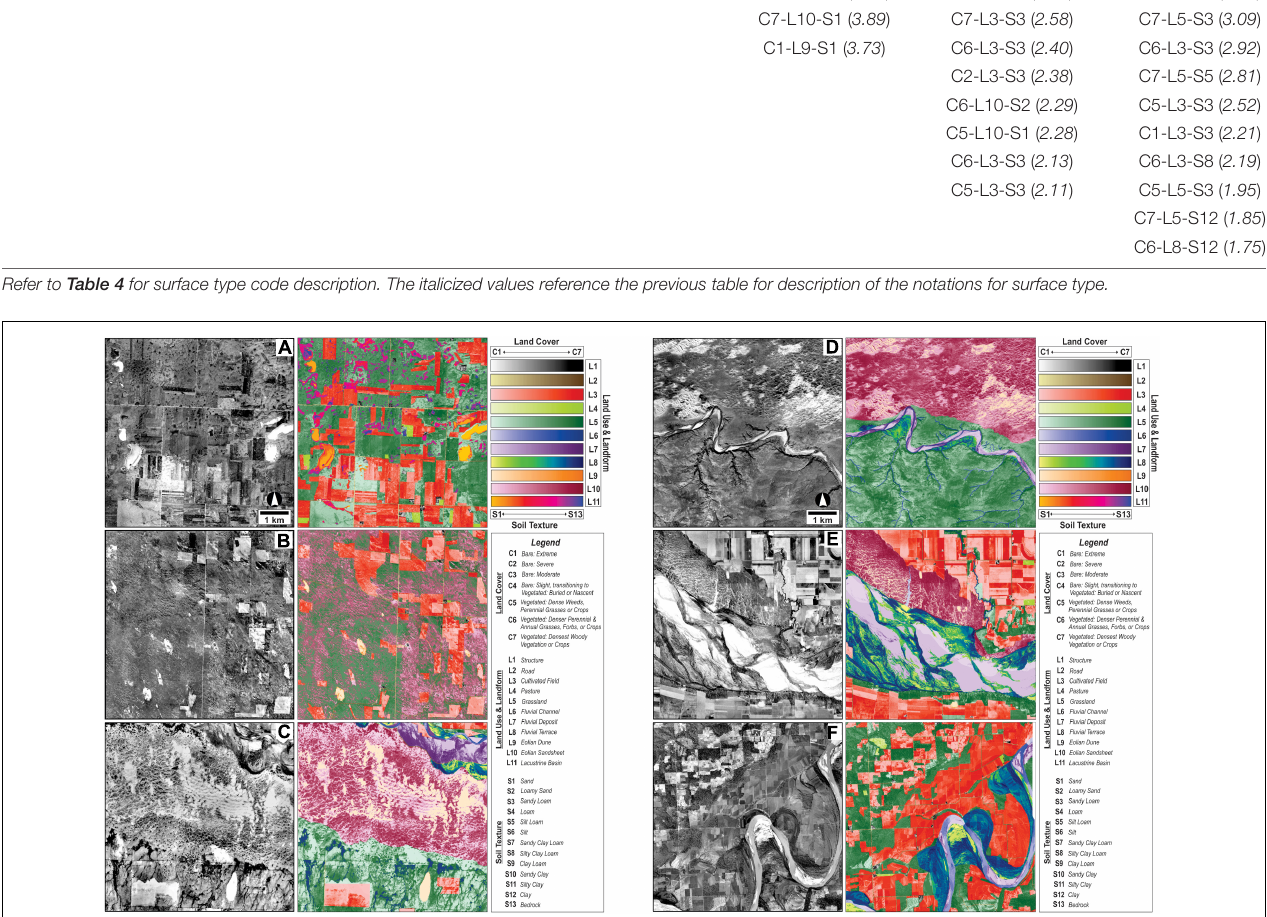
FIGURE 7 | Illustrative samples from image analysis and classification from processed aerial photographs of (A) Ward County, ND, (B) McPherson County, NE, (C) Hamilton County, KS, (D) Quay County, NM, (E) Tillman County, OK, Wilbarger and Wichita Counties, TX, and (F) Choctaw County, OK, Lamar and Red River Counties, TX. Refer to the corresponding letter in Figure 6 for location denoted by a green box. Column one is an enhanced view of ∼ 45 km 2 from the blended mosaic; column two presents the final supervised image classification of landscape